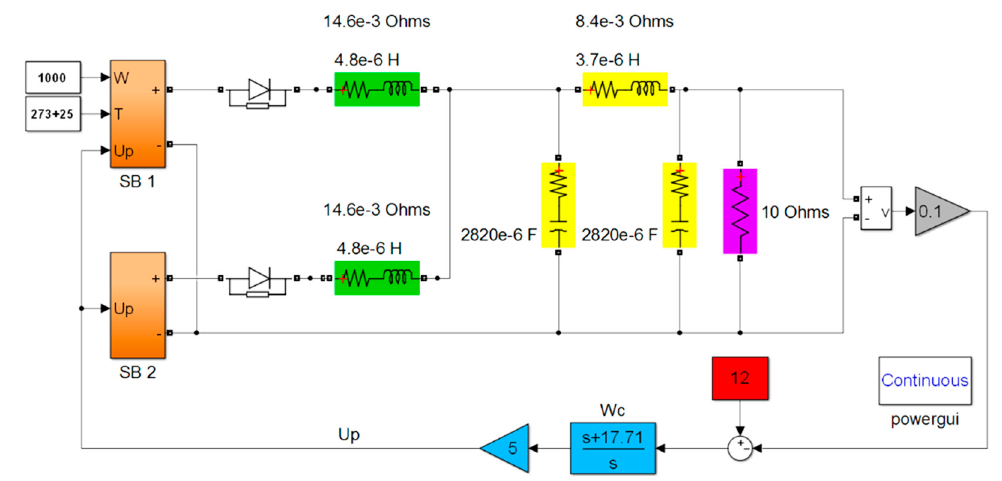
Figure 16. Simulation model of a synthesized control system in MatLab.